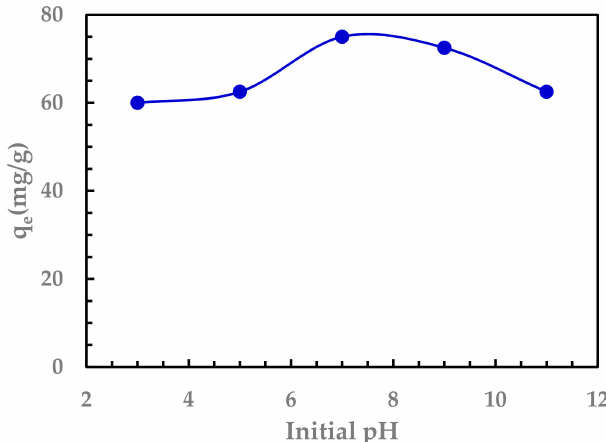
Figure 5. Effect of initial pH on the capacity for Sr (II). Initial Sr (II) concentration: 200 mg/L, volume = 50 mL, agitation using magnetic stirrer 500 rpm at 25 ◦ C, adsorbent dosage 10